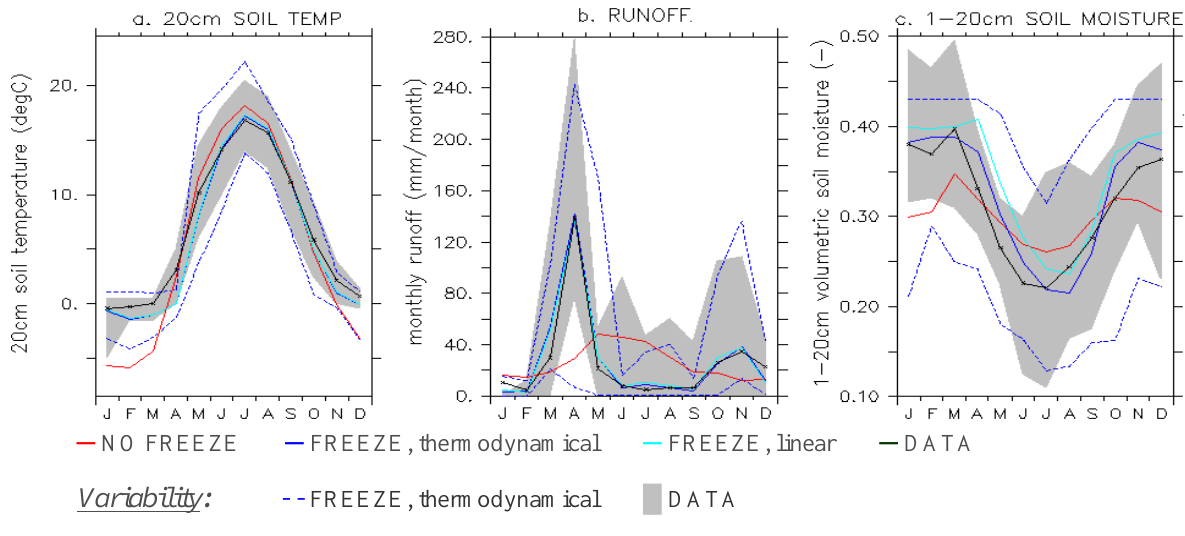
Fig. 6. Annual cycles of monthly mean 20cm soil temperature (a) , monthly mean runoff (b) and monthly mean 1–20cm volumetric soil moisture (c) simulated by ORCHIDEE with (FREEZE) and without (NOFREEZE) the freezing scheme, and compared to available data (DATA) over 1966–1983. The grey and the dashed blue envelopes respectively represent the annual variability in the data and in the FREEZE, thermodynamical